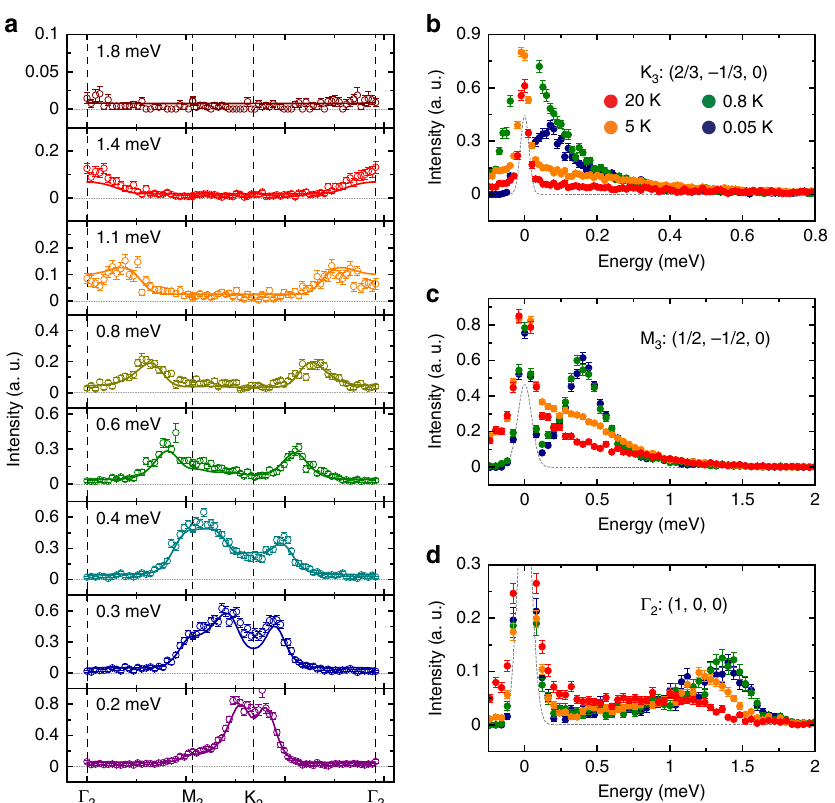
Fig. 4 Constant energy cuts along the high-symmetry directions and constant Q cuts at the high-symmetry points. a Constant energy cuts along the Γ – M – K – Γ direction at the indicated energy at 0.05 K. The solid curves indicate the simulated spin excitations using the model speci fi ed in the text and the vertical dashed lines indicate the high-symmetry points. b – d Constant Q cuts at the K, M and Γ points at various temperatures. The data presented in a , c and d were measured with E i = 4.8 meV while the data in b were measured with E i = 1.7 meV. The gray dashed lines indicate the elastic incoherent scattering. The error bars indicate the standard